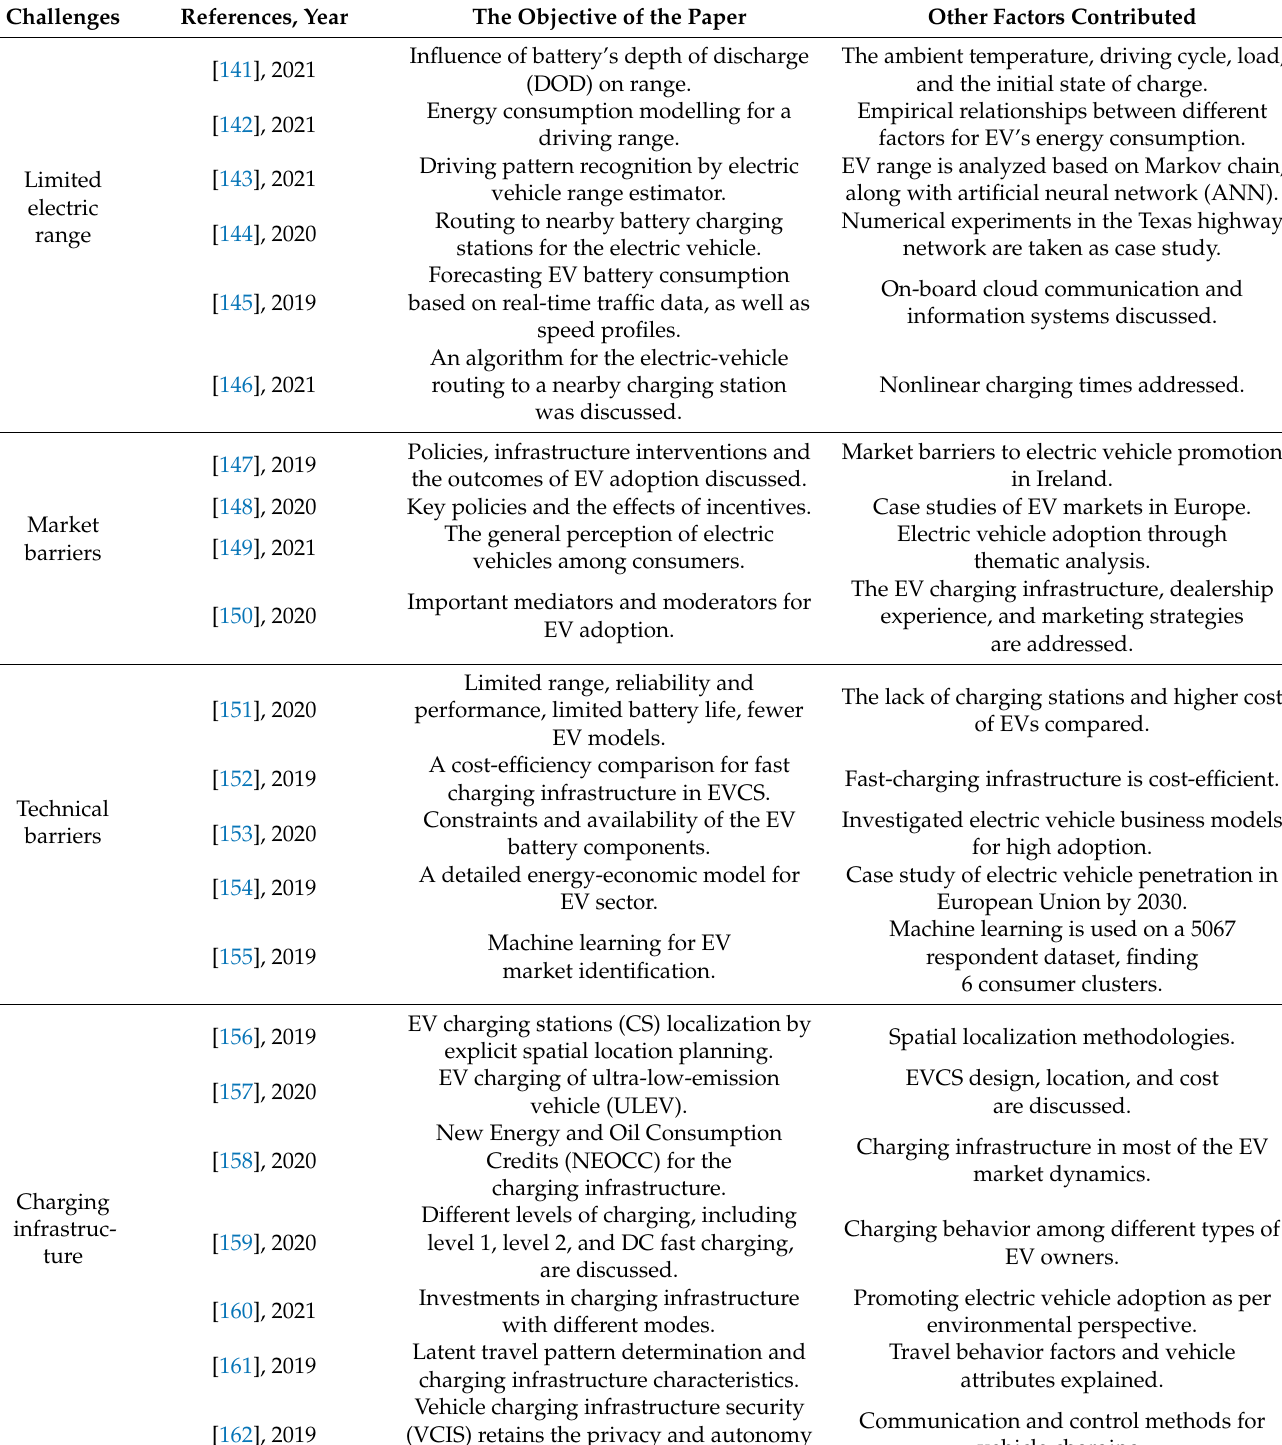
Table 3. Challenges of electric vehicle grid integration as per the recent